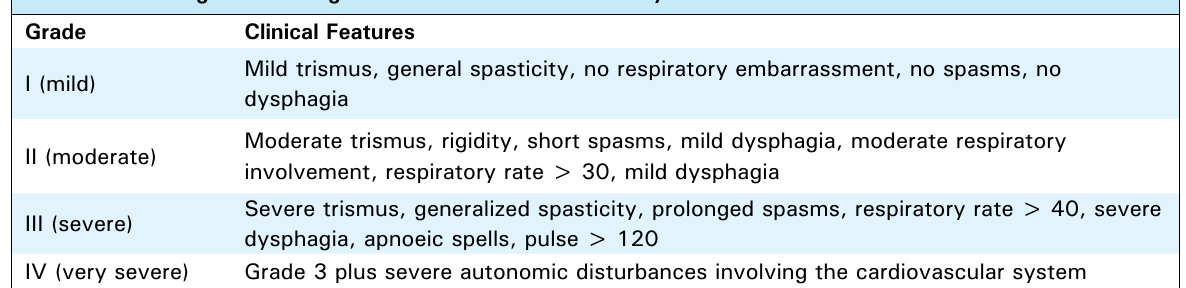
table 1. Showing the Ablett grades classification for severity.